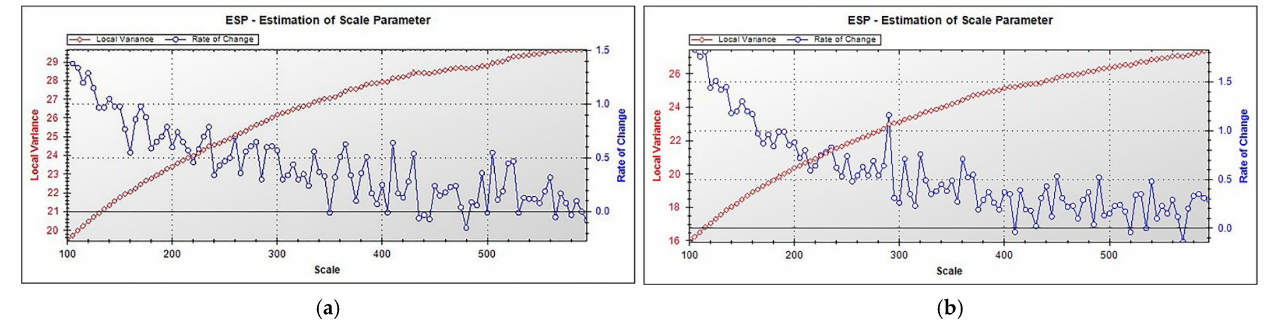
Figure 5. Optimal segmentation scale obtained by ESP under different images: ( a ) original im- age ESP optimal segmentation scale; ( b ) mathematical morphology filter image ESP optimal segmentation